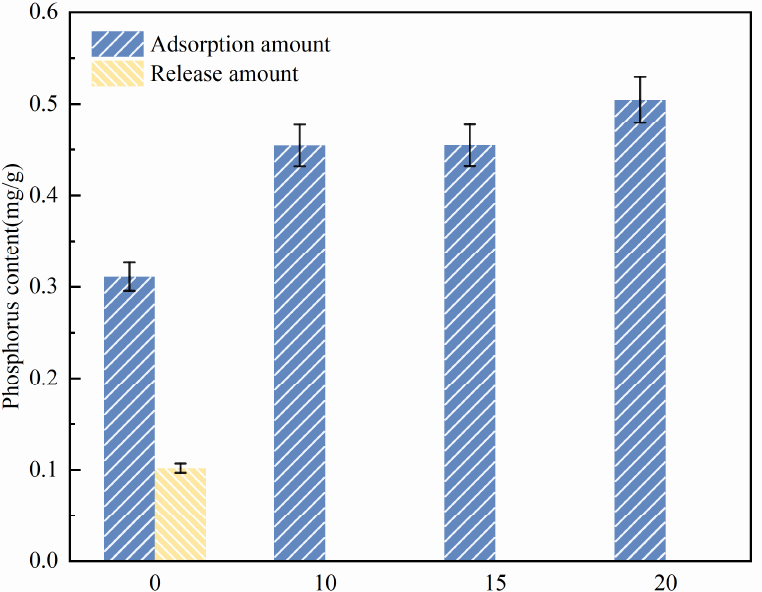
Figure 2. Effect of different concentrations of FeCl 3 ⋅ 6H 2 O on phosphate uptake and